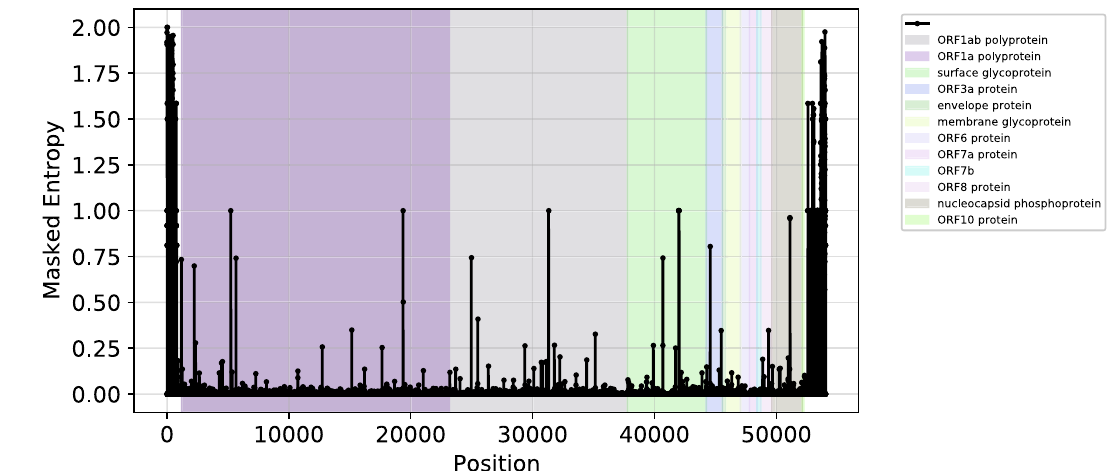
Figure 1. Shows the masked entropies at different genomics positions in the multiple aligned genome sequences of SARS-CoV-2. The different colors indicate coding regions of the genome. The untranslated regions (UTRs) are shown in white color. Note that the two polyproteins ORF1ab and ORF1a are overlapping because both are coded by the same ORF1ab